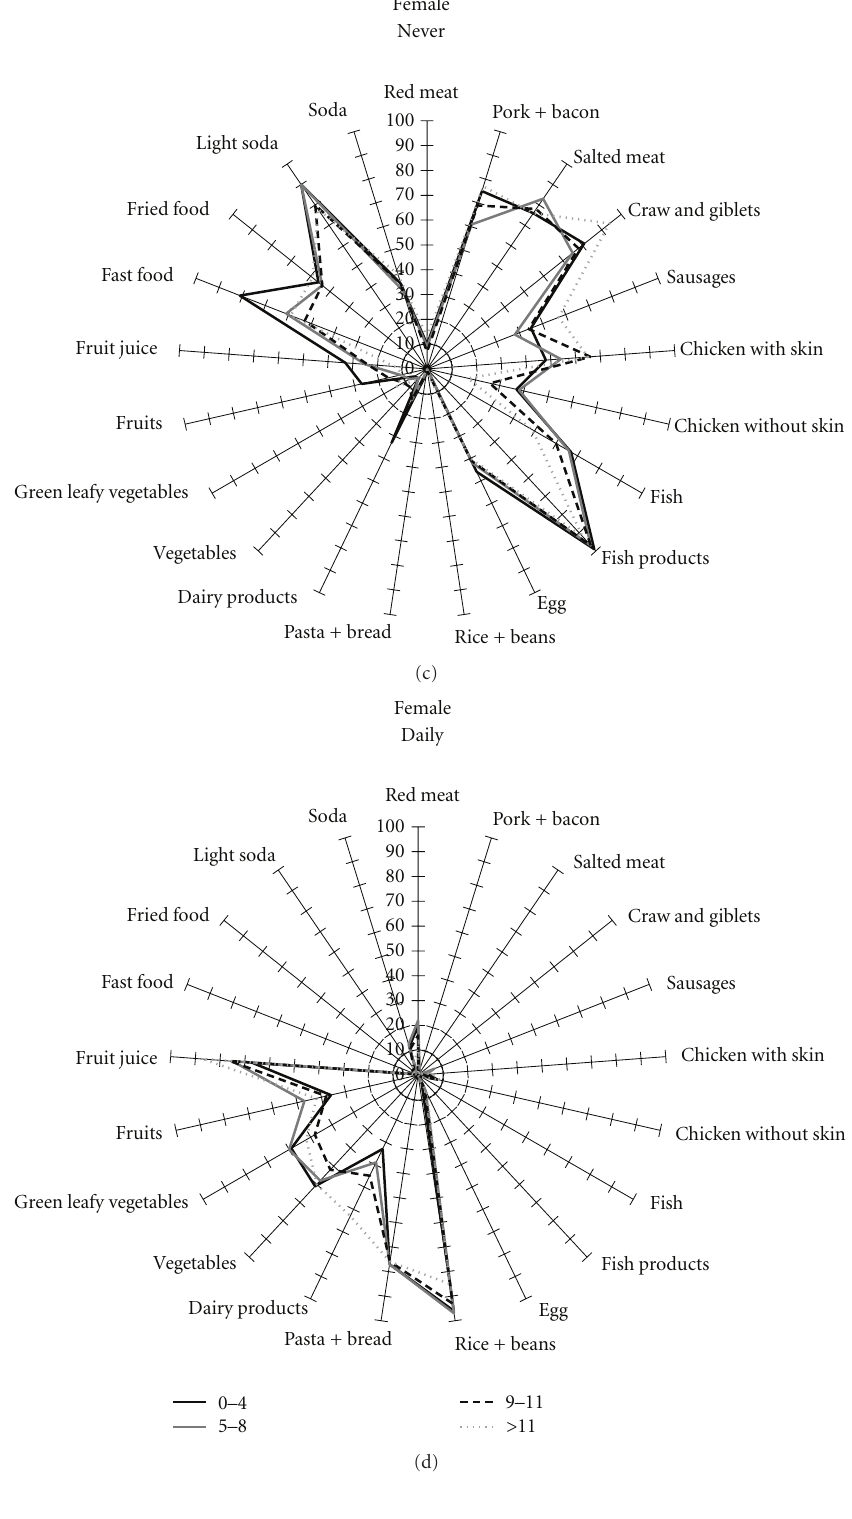
Figure 3: Food frequency consumed daily and never according to education, stratified by sex, SESI